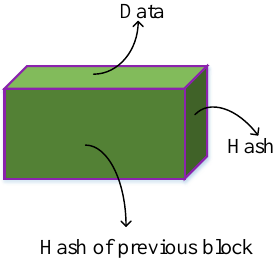
Figure 4. Types of keys in